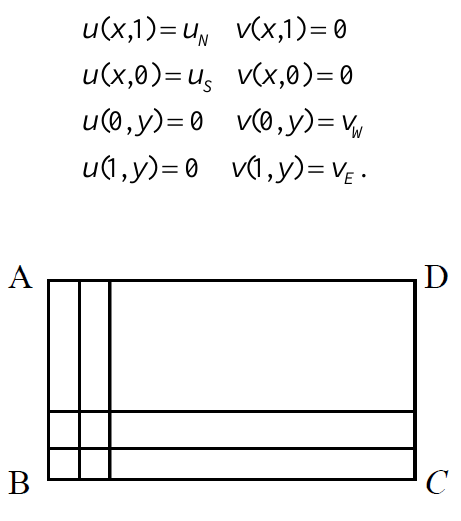
Figure 1. Rectangular